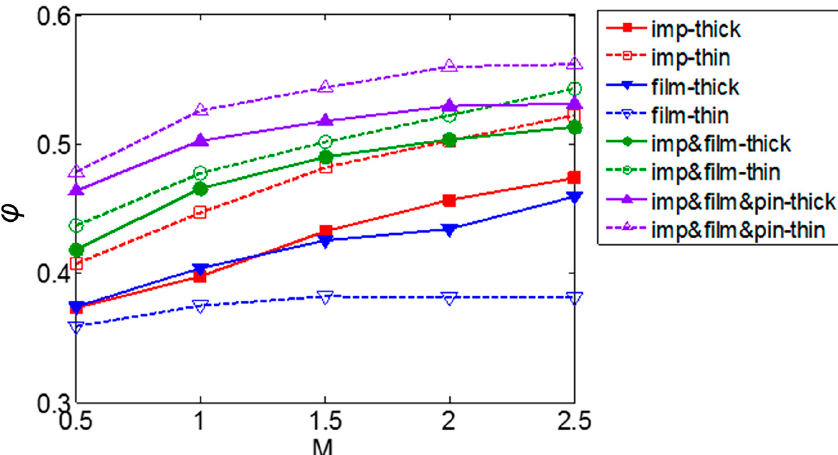
Figure 18. Comparisons of the overall cooling efficiency of various cooling configurations. Reprinted with permission from [100]. Copyright 2019 ASME.